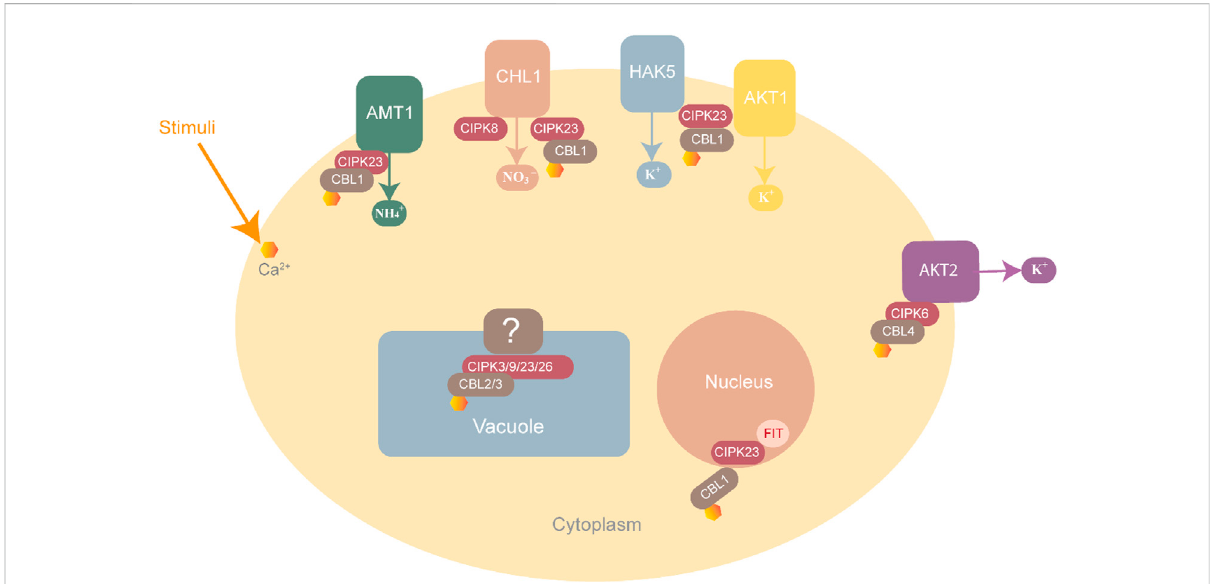
FIGURE 5 CBL-CIPK complexes involved in ion homeostasis. NH 4 + homeostasis is maintained through AMT1 inactivation by the CBL-CIPK23 complex to block entry into the cell. K + homeostasis is maintained by three complexes, CBL1-CIPK23, which interact with HAK5 and AKT1 while CBL4-CIPK6 interacts with AKT2 for K + uptake into the cell. NO 3 homeostasis is maintained by CIPK8 and CIPK23, which interact with CHL1 as positive and negative regulators